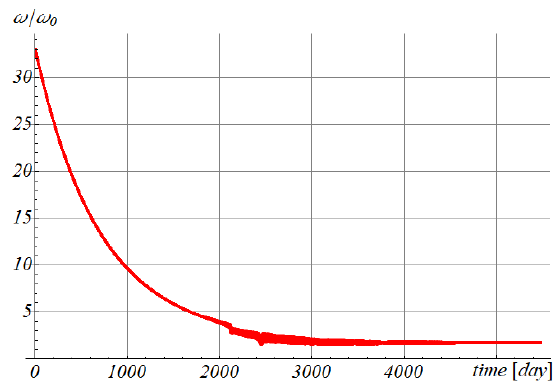
Figure 5. Angular velocity to orbital angular velocity ratio ω / ω 0 in the exponential deceleration